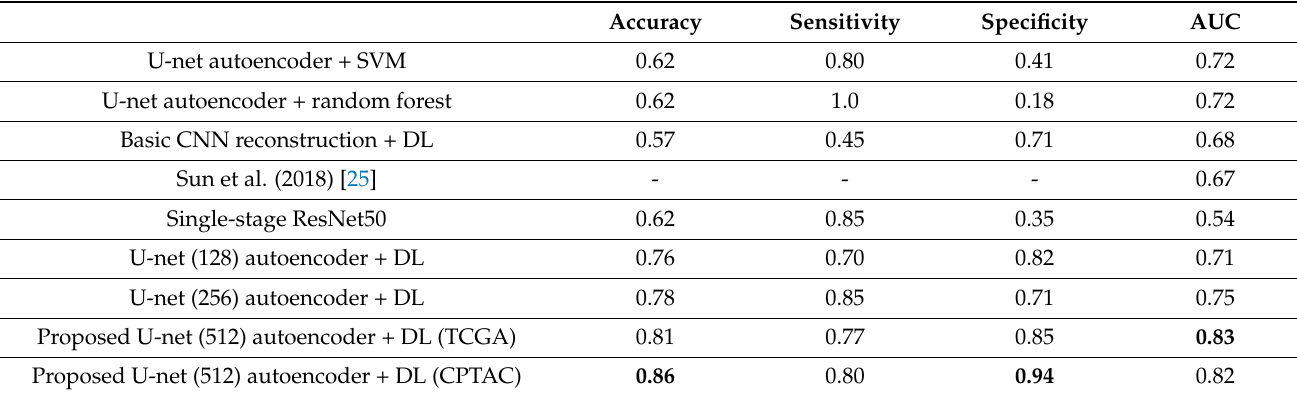
Table 3. Performance comparison of various